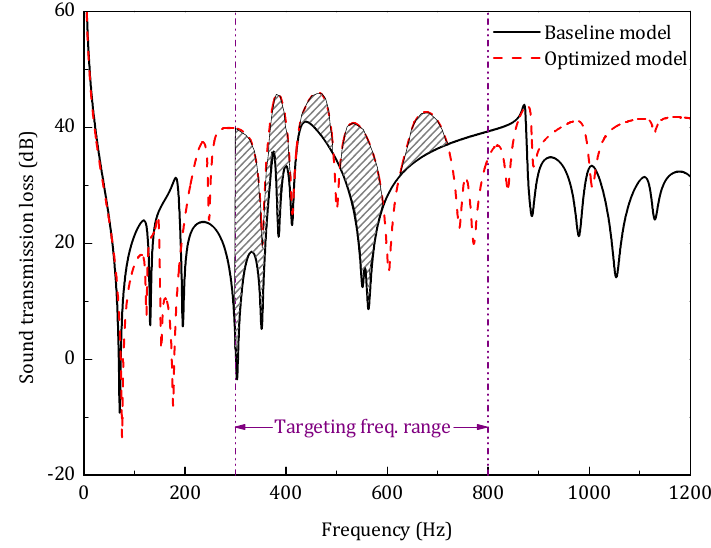
Figure 23. Sound transmission loss of the optimized model in mid-frequency range.